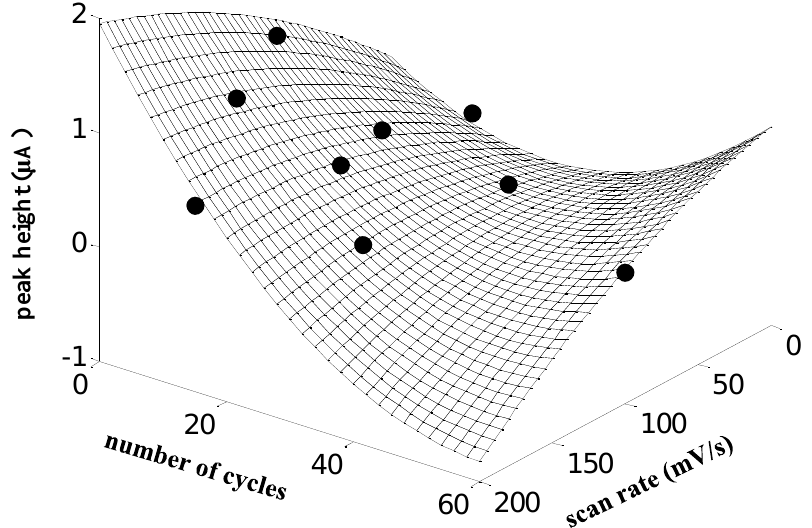
Figure 1. Effect of the number of voltammetric cycles and scan rate on the peak height of HCTZ on SPCE/PGA. Conditions: 100.0 µmol L − 1 of HCTZ in 0.01 mol L − 1 HCl by DPV. Black points indicate